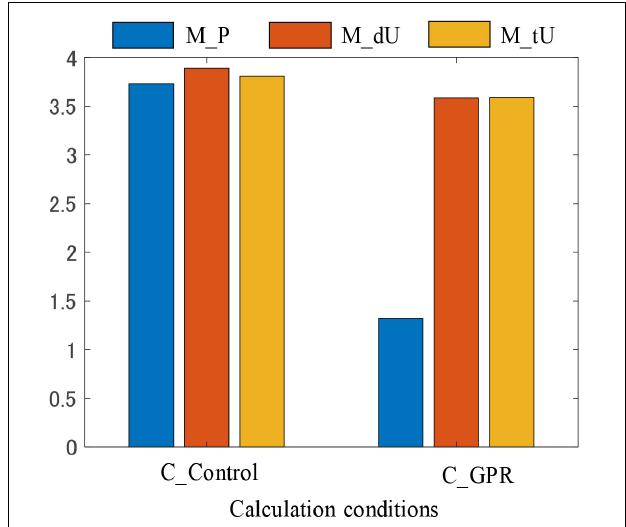
FIGURE 6 | Predicted motion sickness incidence under different